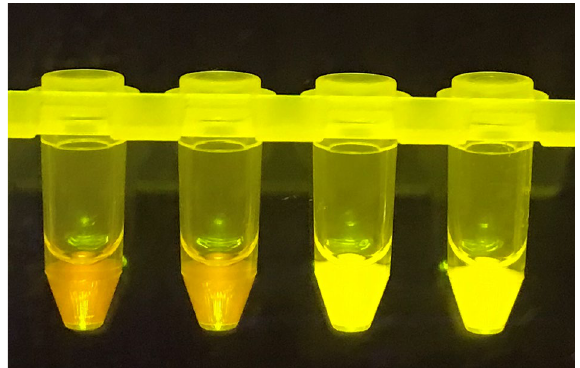
Figure 1. Visual results of Saliva-Dry LAMP reactions as viewed under a blue light transilluminator. The two reactions on the left are negative (orange) and the two reactions on the right (bright green) are positive read